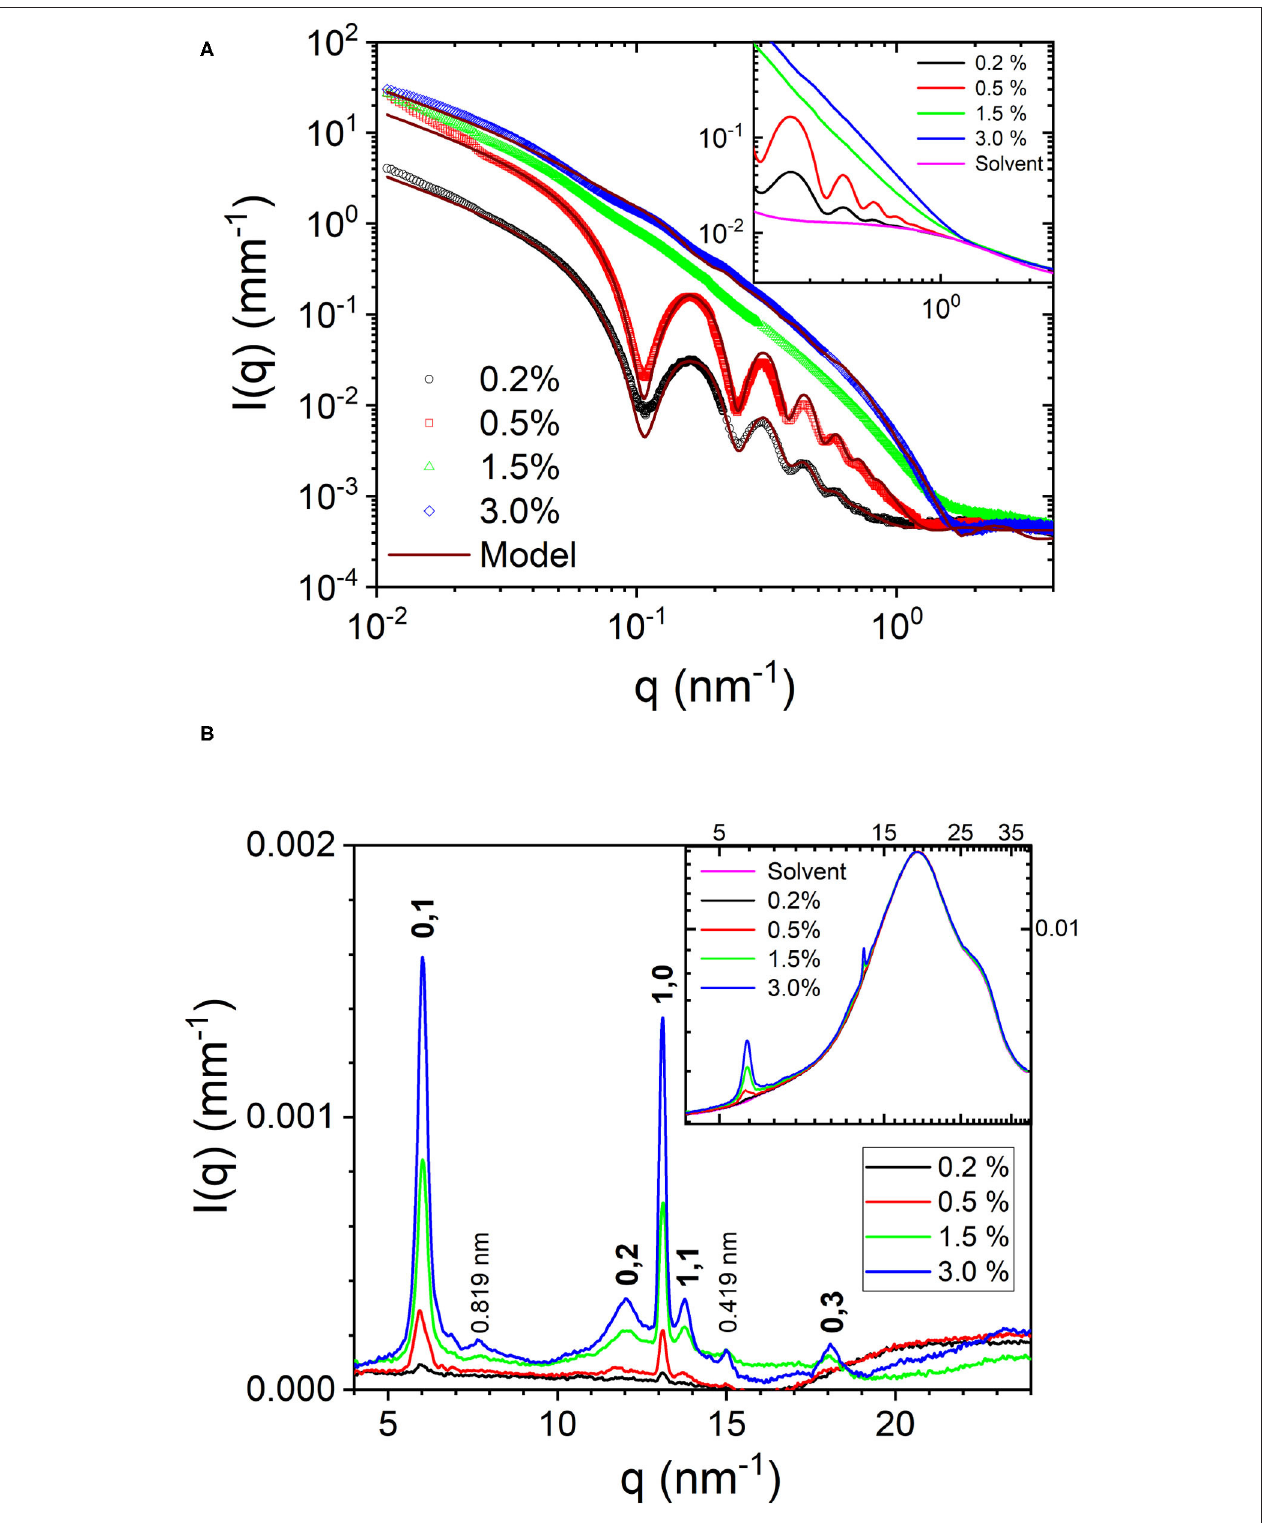
FIGURE 2 | (A) Normalized SAXS profiles from A β (16-22) peptide at four concentrations over the full q range of measurement. The inset displays the background unsubtracted profiles and highlights the importance of accurate background subtraction. (B) Corresponding WAXS profiles for the four peptide concentrations and indexation of the Bragg peaks (the spacings of which are specified in the text). The inset depicts the strong solvent background scattering.